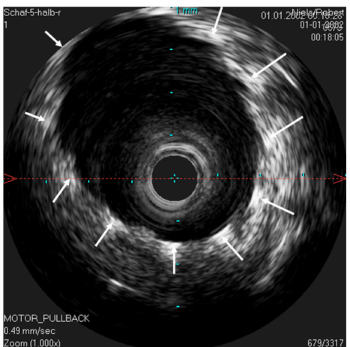
Figure 7. Ultrasound image of the stented ET. The lumen of the ET is opened by the unfolded stent. The IVUS probe is located in the lumen of the stent. The stent struts can be seen echogenically, and sonic extinction is marked with white arrows. Note: the ET was flooded with water before the scan to allow for sonic